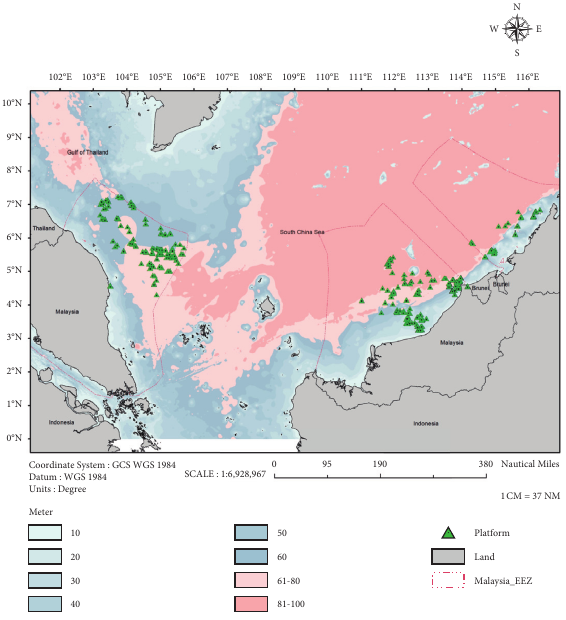
Figure 4: Bathymetry map of the water region in